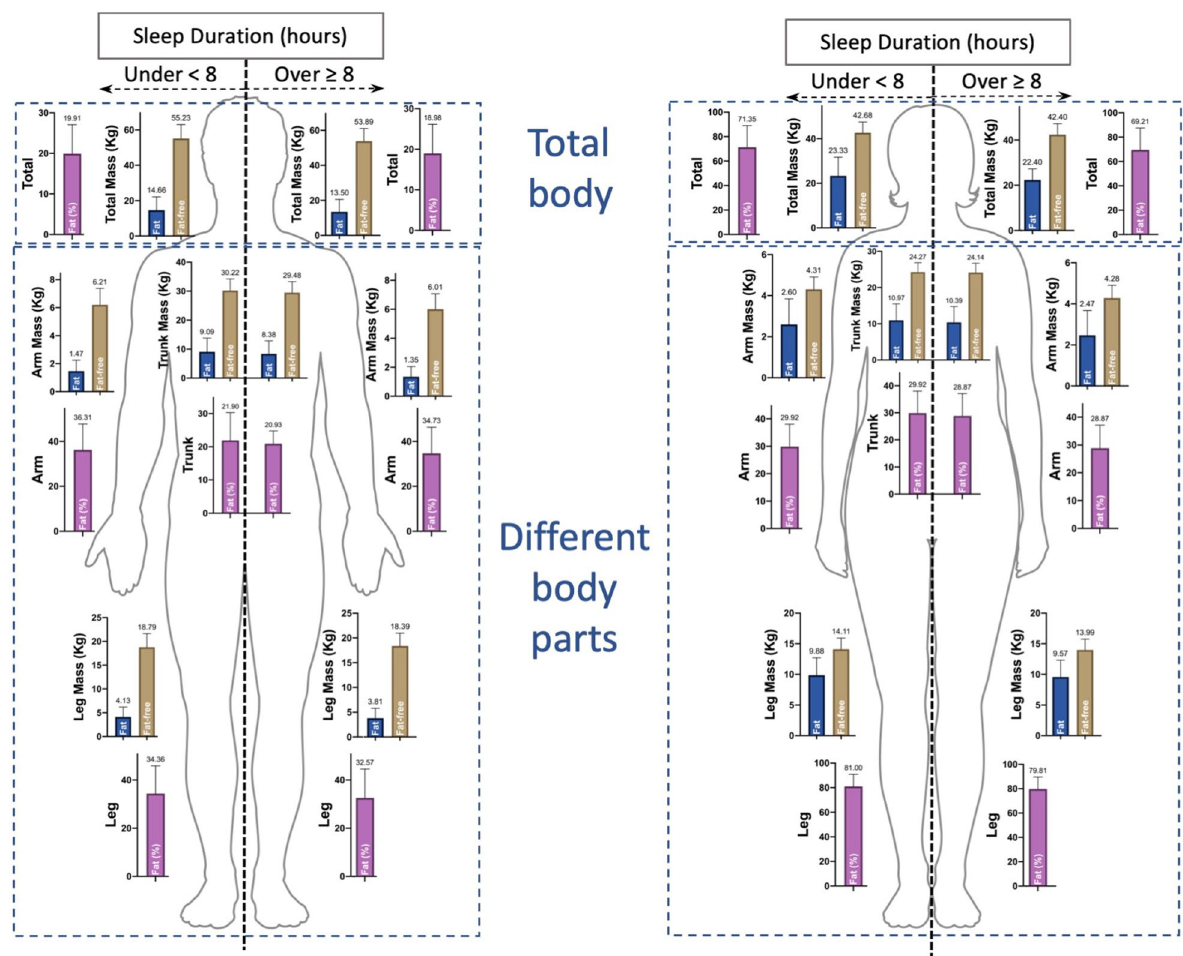
Figure 1. The schematic graphs of body fat composition data in total and different body parts in both